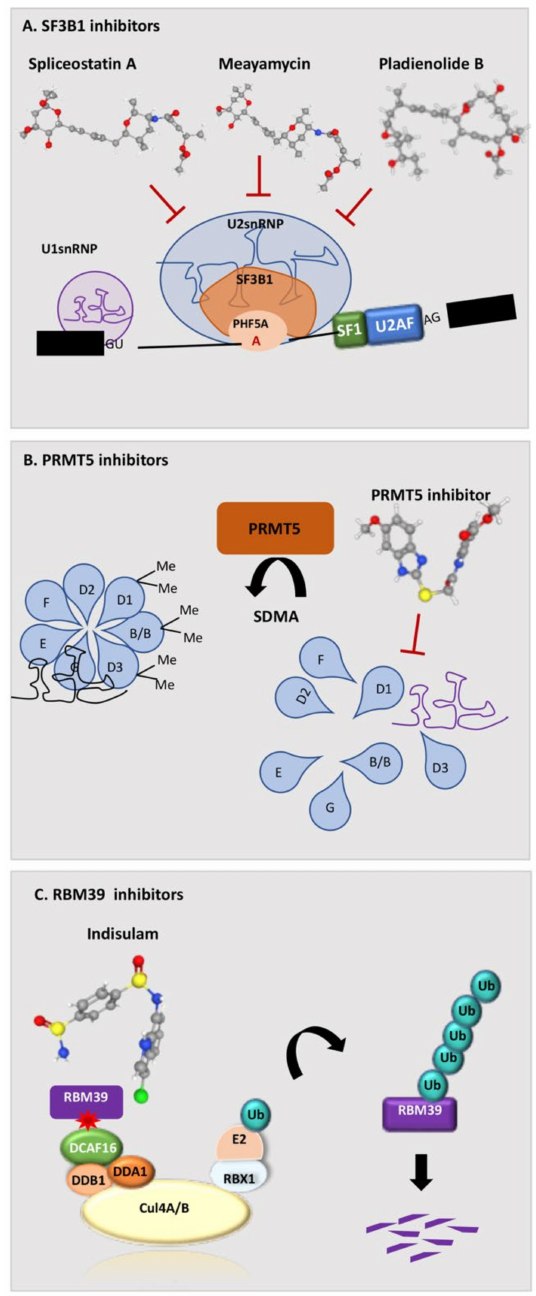
Figure 3. Splicing-based therapeutic strategies in cancer. ( A ) SF3B1 binding agents, including spliceostatin A, meayamycin, and Pladienolide B, interact with SF3B1, thus blocking its binding to the branch point. ( B ) PRMT5 inhibitors inhibit PRMT5-mediated symmetric demethylation of arginines’ (SDMA) on Sm (D1, B/B, D3) proteins, which is required for spliceosome assembly. ( C ) Indisulam links the E2 ubiquitin ligase complex to RBM39 through the adaptor DCAF15, thus leading to polyubiquitination of RBM39 and its proteasome-mediated